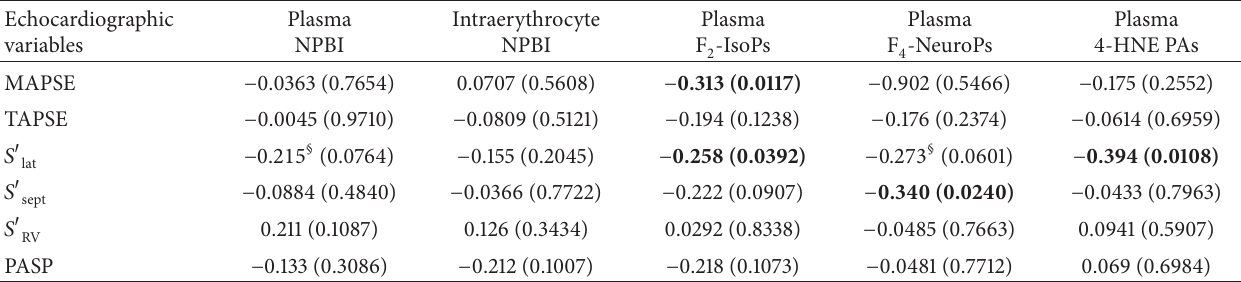
Table 2: Correlation matrix for OS markers and myocardial function variables in RTT patients following 𝜔 -3 PUFAs supplementation.